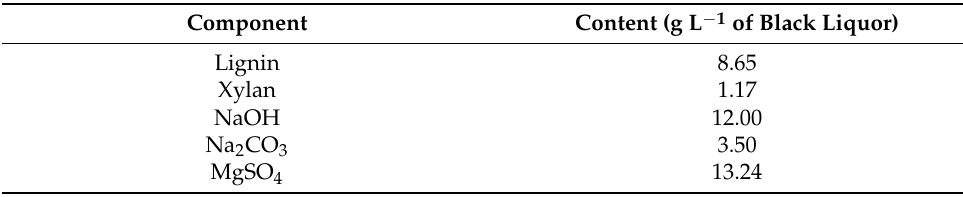
Table 4. Composition of the simulated black liquor used in the experiments.